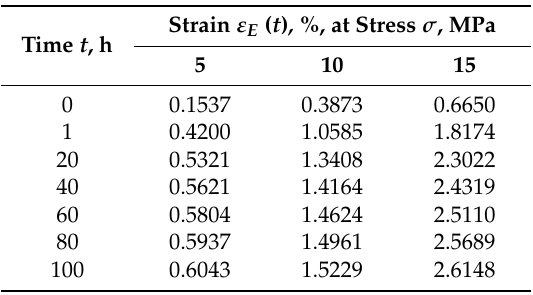
Table 1. Creep strain values of material Nylon